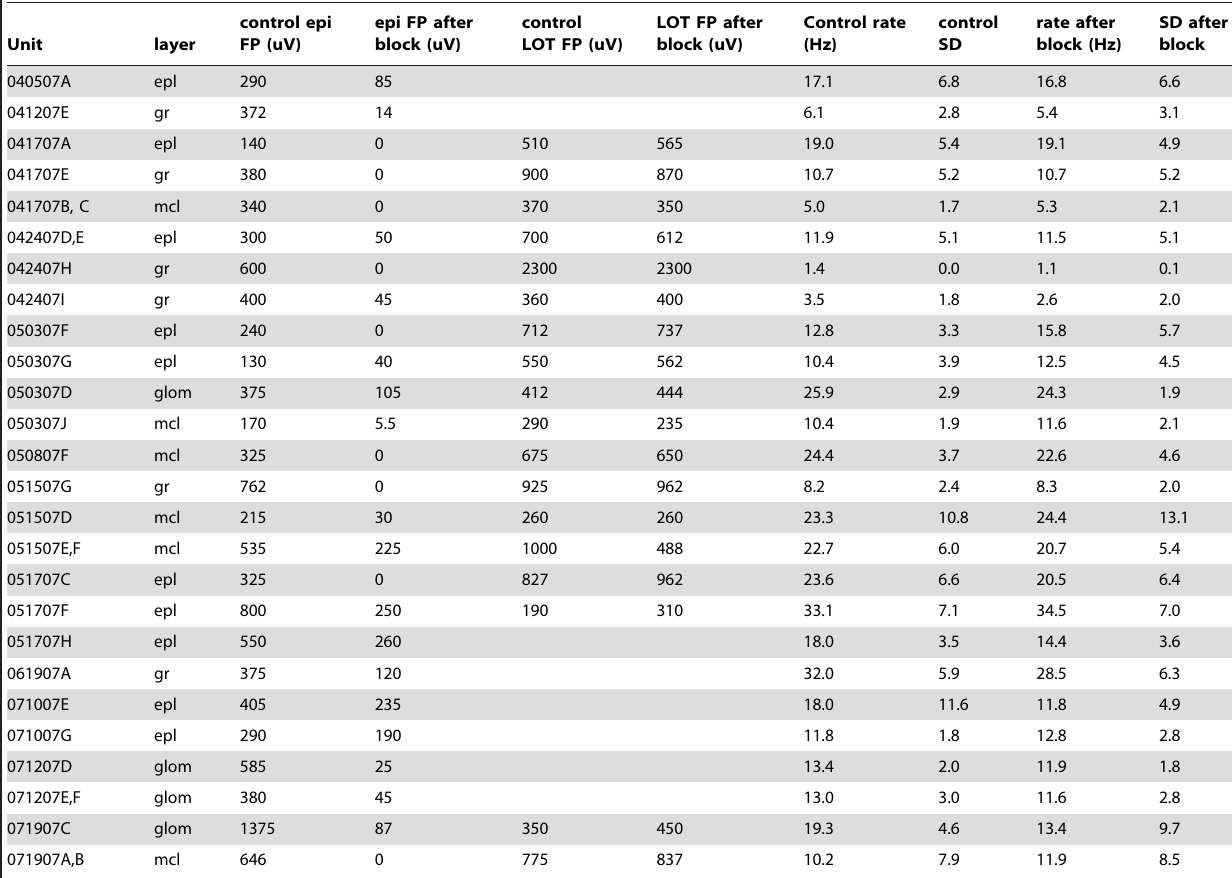
Table 1. Effects of ON block on MOB